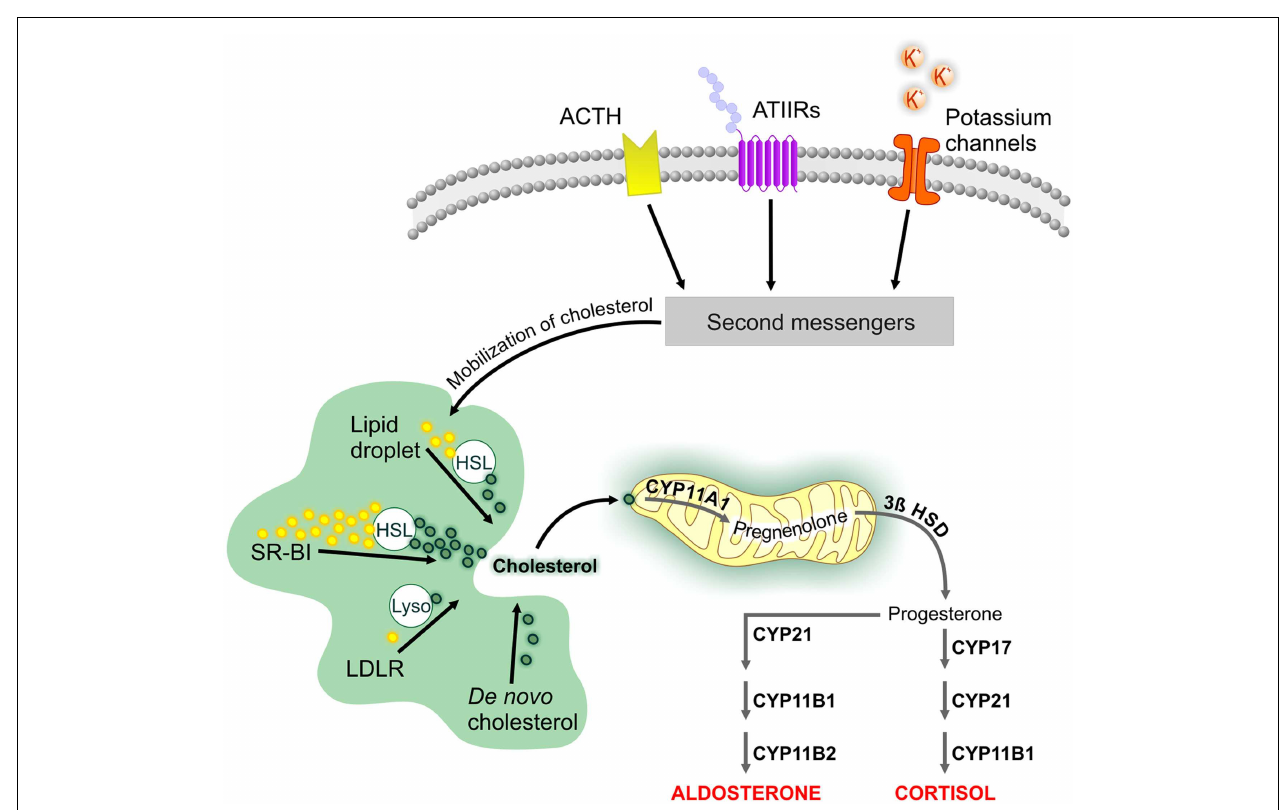
initiate cholesterol mobilization. Cholesterol can be obtained from LDL and HDL lipid carriers, lipid droplets, or de novo synthesis. Unesterified cholesterol is transported to the mitochondria, where cleavage by CYP11A1 is the first step of steroidogenesis.Tissue-specific expression in the various zones of the adrenal cortex leads to aldosterone and cortisol biosynthesis. Abbreviations: 3 β HSD, 3 β -hydroxysteroid dehydrogenase; HSL, hormone-sensitive lipase; LDLR, low-density lipoprotein receptor; SR-BI, scavenger receptor class